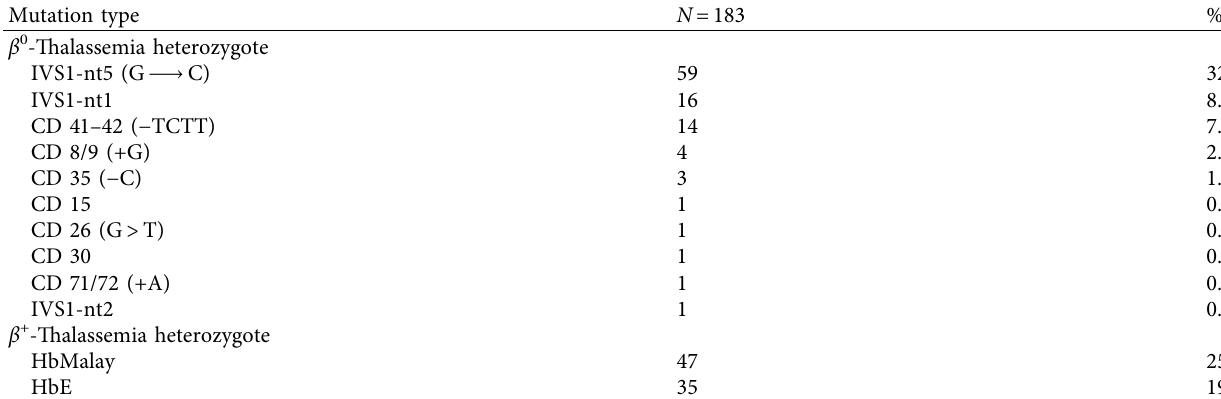
Table 2: Types of β -thalassemia mutations found in the present study ( n �